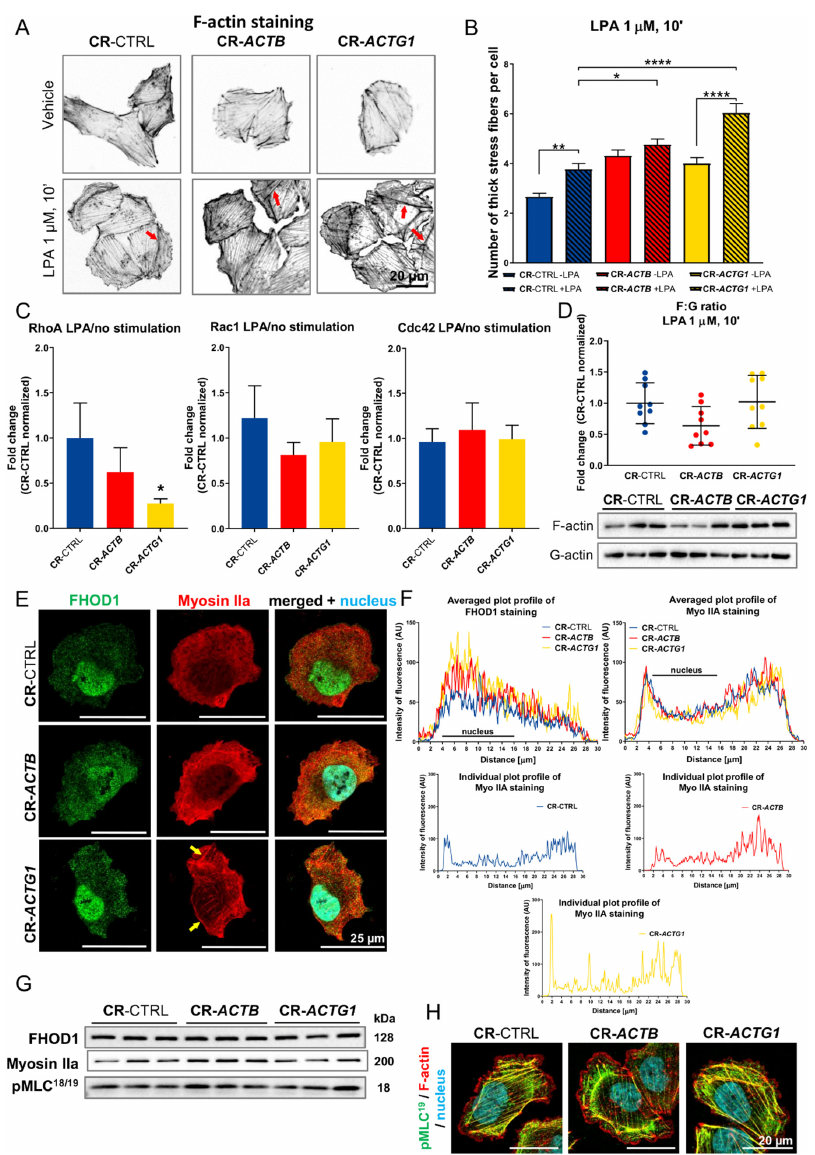
Figure 4. Stress fibers’ formation is disturbed in clones devoid of β or γ actin. ( A ) CR-CTRL, CR- ACTB, and CR- ACTG1 cells upon stimulation with LPA were fixed and stained with Alexa Fluor ™ 488 phalloidin. Red arrows point at stress fibers. ( B ) The number of thick stress fibers was calculated for every condition and presented as a bar chart ( n = 61–81). ( C ) Activity of RhoA, Rac1, and Cdc42 was estimated after lysophosphatidic acid (LPA) stimulation ( n = 3). ( D ) F:G actin ratio was evaluated in the cells on the base of Western blot analysis of F- and G-actin levels in studied clones ( n = 9). Membranes were incubated with anti-total actin antibodies. ( E ) The cells were immunostained with antibodies detecting the human FH1 / FH2 domain-containing protein 1 (FHOD1) and Myosin IIa. Yellow arrows highlight Myosin IIa accumulation. ( F ) Plots of averaged ( n = 9) and individual fluorescence intensity distribution for FHOD1 and Myosin IIa staining across a cell. ( G ) Western blot analysis of cell lysates. Membranes were probed for FHOD1, Myosin IIa, and myosin light chain phosphorylated at Thr18 and Ser19 (pMLC 18 / 19 ). Corresponding densitometric analysis and Ponceau S stainings of membranes are shown in Figure S9. Forty µ g of protein was loaded on every lane. ( H ) The cells were stained with anti-pMLC 19 antibodies and fluorescently labeled phalloidin. Results are expressed as the mean ± SD ( C , D ) or ± SEM ( B ), p ≤ 0.05 (*), p ≤ 0.01 (**), p ≤ 0.0001